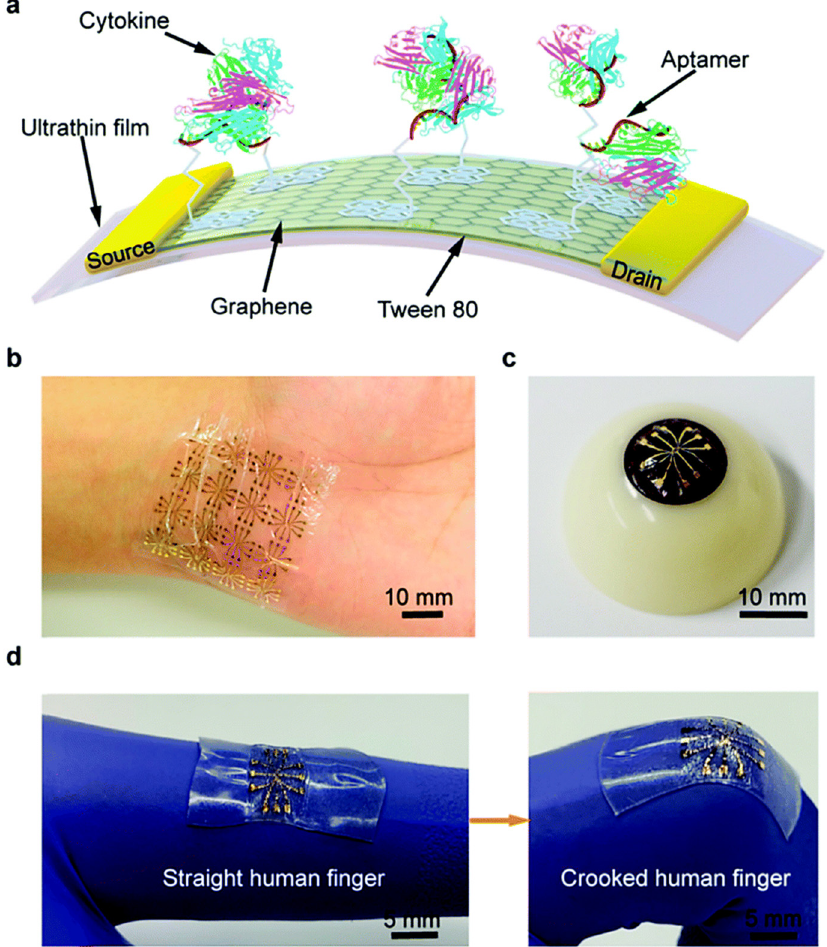
Figure 14: ( a ) Schematic of the GFET biosensor, ( b ) human wrist and ( c ) arti fi cial eyeball, and ( d ) a stretchable biosensor can be stretched with the activity of the human body [ 107 ]